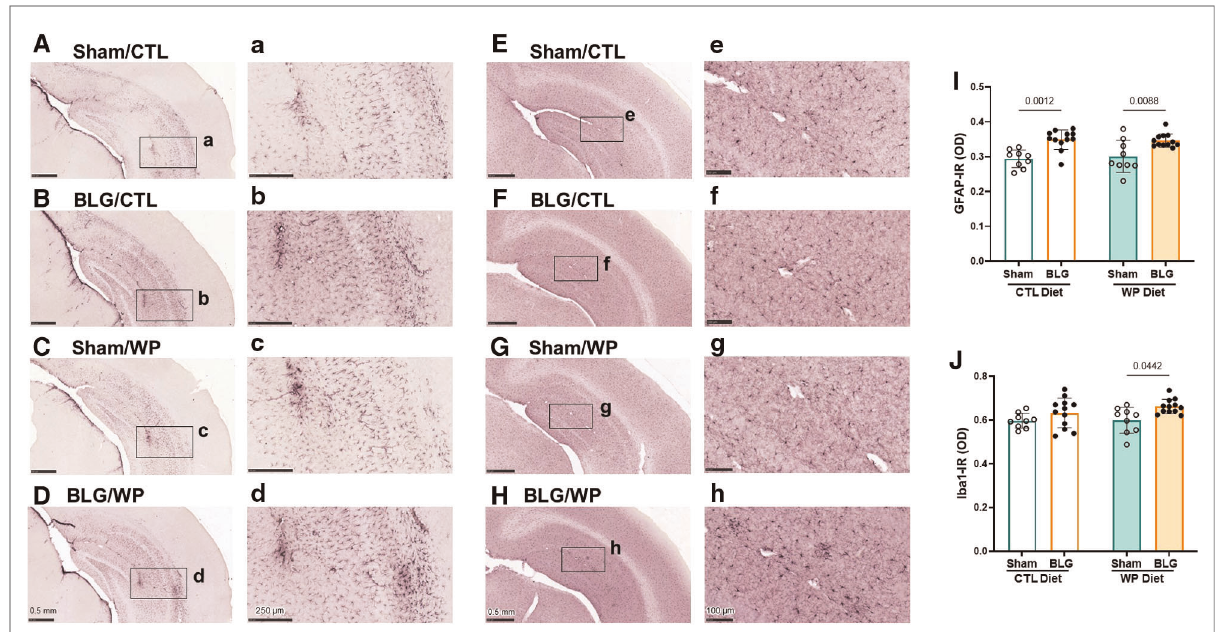
FIGURE 5 Immunohistochemical staining of GFAP and Iba1 in the brain. GFAP-positive astrocytes ( A – D ) and Iba1-positive microglia ( E – H ) were immunohistochemically identi fi ed in the brain sections from sham mice with the CTL diet ( A,E ), BLG mice with the CTL diet ( B,F ), sham mice with the WP diet ( C,G ), and BLG mice with the WP diet ( D,H ). The panels with lowercase letter labels in the right columns ( A – H ) depict high magni fi cation images taken from the region indicated by the black rectangles in the corresponding photomacrographs ( A – H ). The low- magni fi cation images were taken with 4X ( A – D ) or 4.5X ( E – H ) objectives, and the high-magni fi cation images were taken with 14X or 20X objectives. Scale bars: 0.5 mm ( A – H ); 250 μ m ( a – d ); 100 μ m ( e – h ). The optical density (OD) of GFAP ( I ) and Iba1 ( J ) immunoreactivity (IR) within the hippocampal region was quanti fi ed using the QuPath image analysis software. Values indicate the group average±SEM. Signi fi cant p -values are shown. Two-way ANOVA, n =9 – 12 per